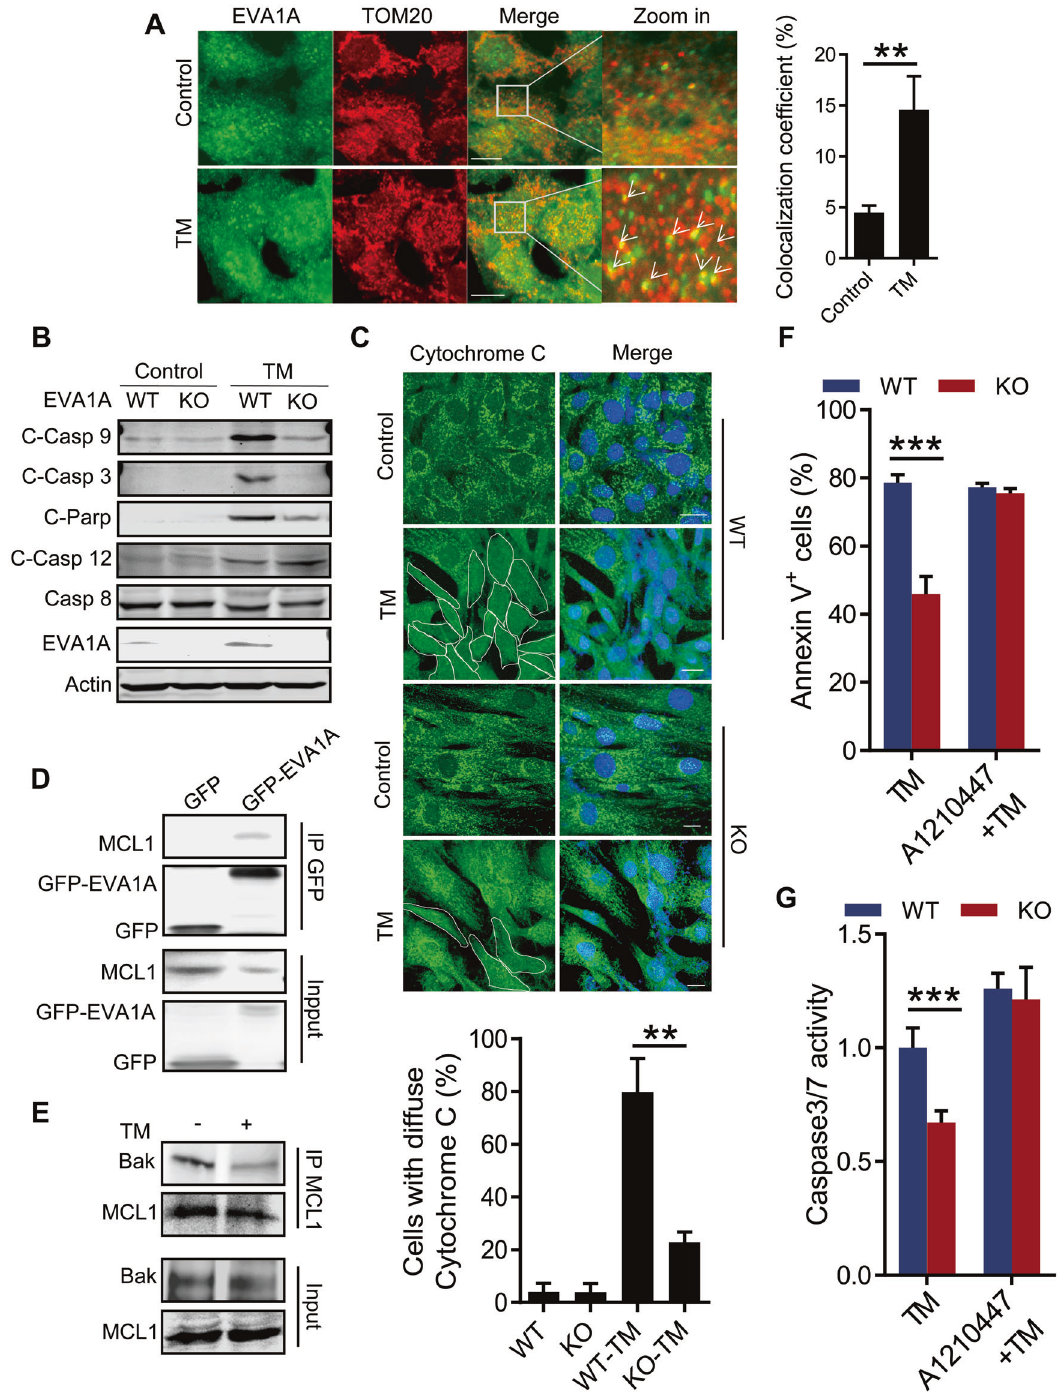
Fig. 6 ER stress-induced EVA1A and MCL1 interaction stimulates mitochondria-associated apoptosis. A Representative images (left) and quanti fi cation (right) showing the colocalization of EVA1A and TOM20 in MEF cells treated without or with 3 μ g/ml Tunicamycin (TM) for 48 h. The colocalization coef fi cient was represented as percentage of signals of EVA1A that were positive for TOM20. Quanti fi cations were performed using Volocity software ( n > 20 cells). Scale bar, 10 μ m. B Western blot analysis of the cleaved Caspase 9, cleaved Caspase 3, cleaved Caspase 12, cleaved PARP and Caspase 8 proteins level in WT and Eva1a knockout MEF cells treated without or with 3 μ g/ml TM for 48 h. C Representative images (top) and quanti fi cation (bottom) showing cytochrome C localization in WT and Eva1a knockout MEF cells treated without or with TM for 24 h ( n > 35 cells). Scale bar, 20 μ m. D HEK293 cells expressing GFP or GFP-EVA1A were treated with 3 μ g/ml TM for 48 h and immunoprecipitated with anti-GFP antibody, then the immunocomplexes were analyzed by Western blot. E HEK293 cells were